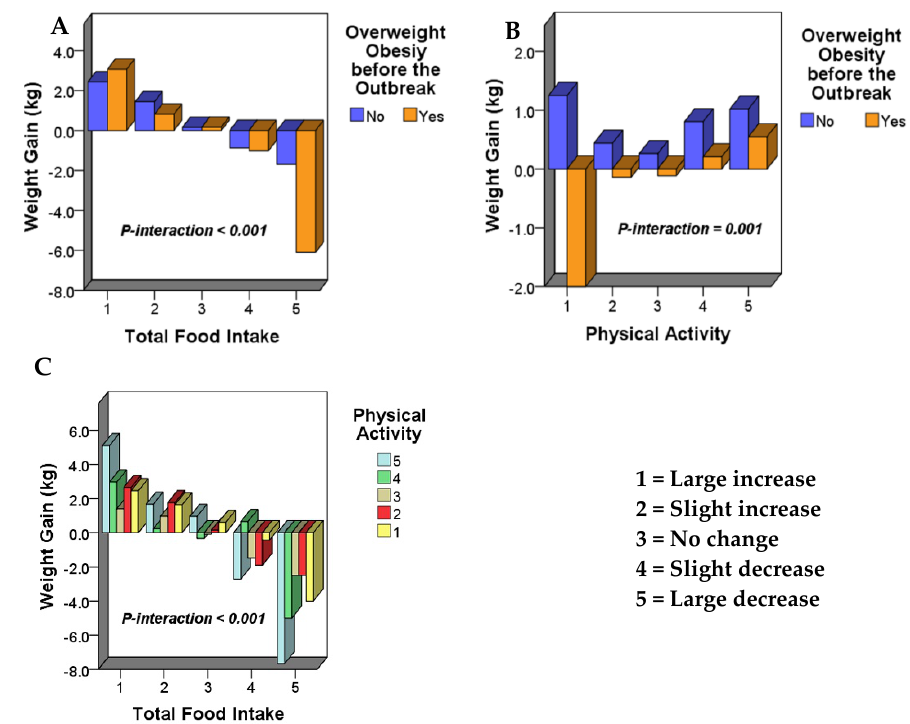
Figure 1. ( A ) The interaction between changes in total food intake and whether overweight/obesity before the outbreak on weight gain. ( B ) The interaction between changes in physical activity and whether overweight/obesity before the outbreak on weight gain. ( C ) The interaction between the changes in total food intake and physical activity on weight gain.